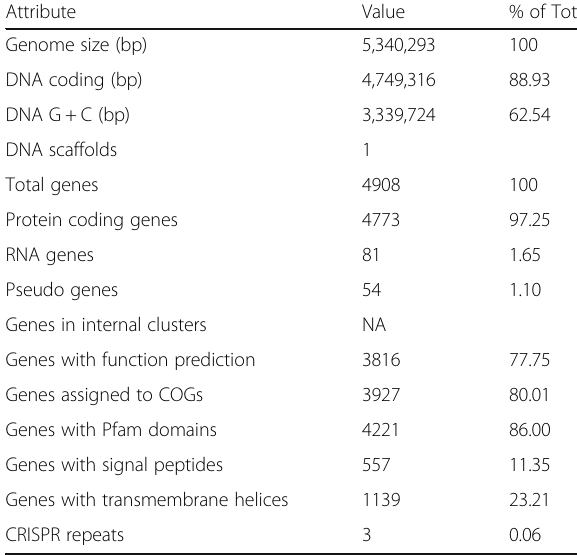
Table 4 Number of genes associated with general COG Table 3 Genome